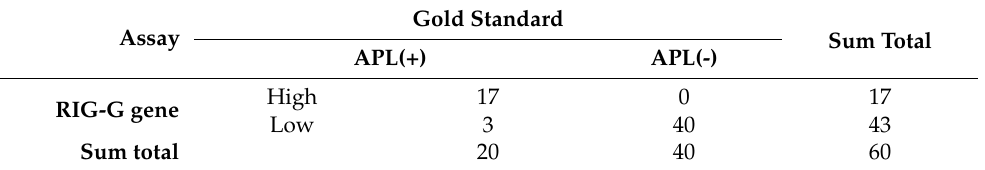
Table 2. Consistency of RIG-G gene expression and bone marrow cell